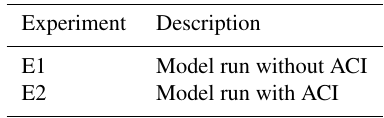
Table 1. The setup of two experiments in the